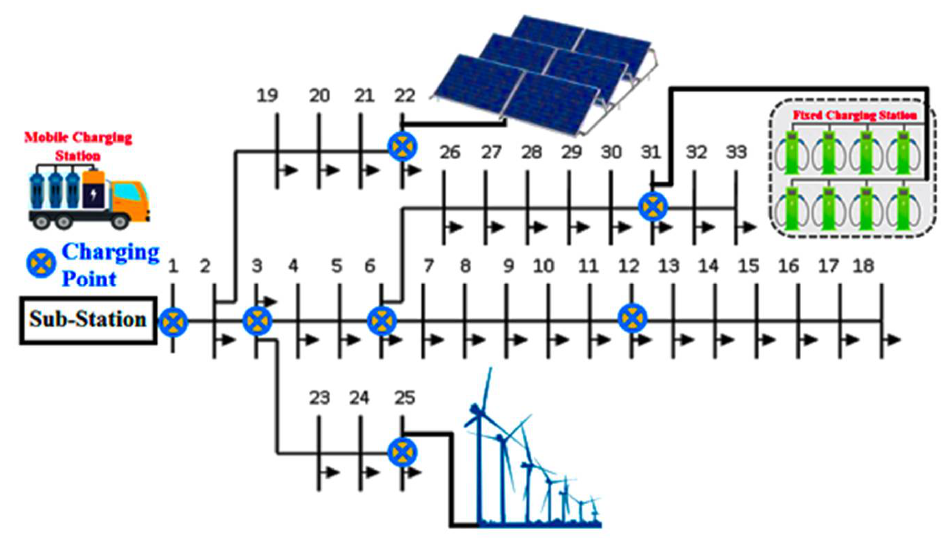
Figure 3. Layout of the 33-bus distribution test system along with the modifications.